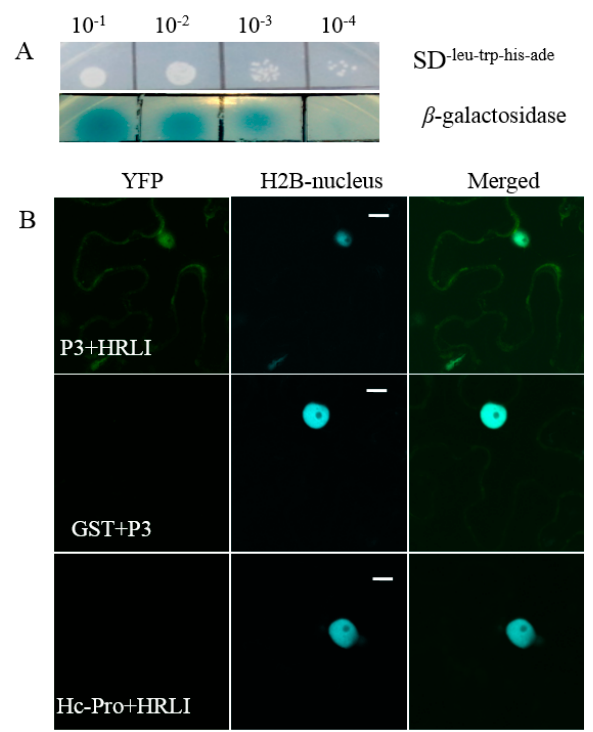
Figure 3. Interaction of soybean mosaic virus (SMV-P3) and the GmHRLI protein. ( A ) Confirmation of the interaction of P3 with candidate interactors in yeast NMY51 cells, and the interaction intensity shown by tipping di ff erent concentrations of interaction solution. Each result was representative of three biological repeats. ( B ) The interaction of GmHRLI and P3 shown in Nicotiana benthamiana . Transgenic Nicotiana benthamiana expressing CFP-H2B (nuclear localized histone 2B) were used for theBiFC assays. Scal bar = 10 µ m. GST and Hc-Pro were used as control, respectively. Images are representative of three separate infiltrations from two independent experiments for each interaction.